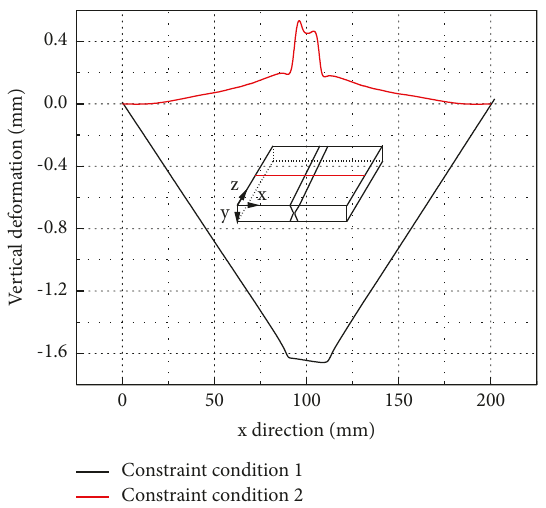
Figure 25: Effect of the constraint conditions on the vertical